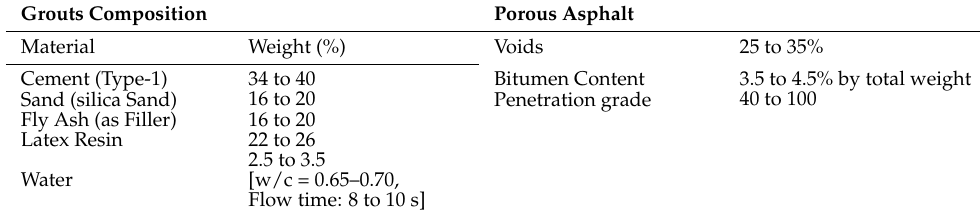
Table 5. Grout composition and porous asphalt job mix formula for RMP [90].